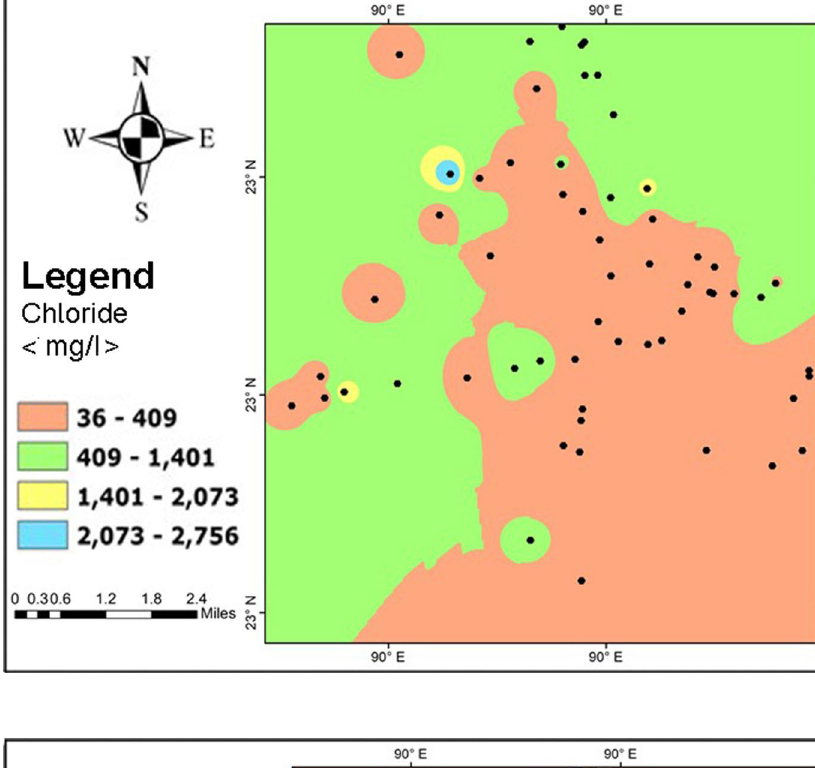
Fig. 8 Spatial distribution of total hardness in selected tube wells